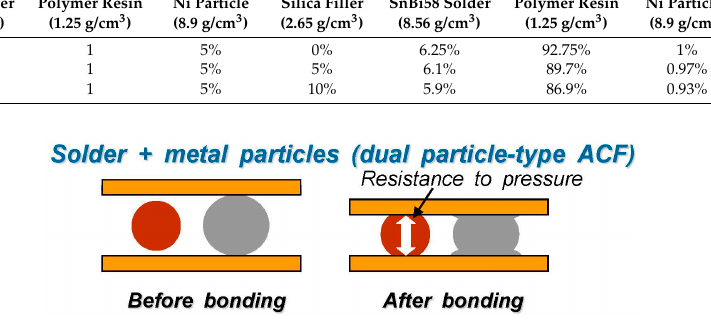
Figure 6. Role of Ni spacer at solder ACFs joints.